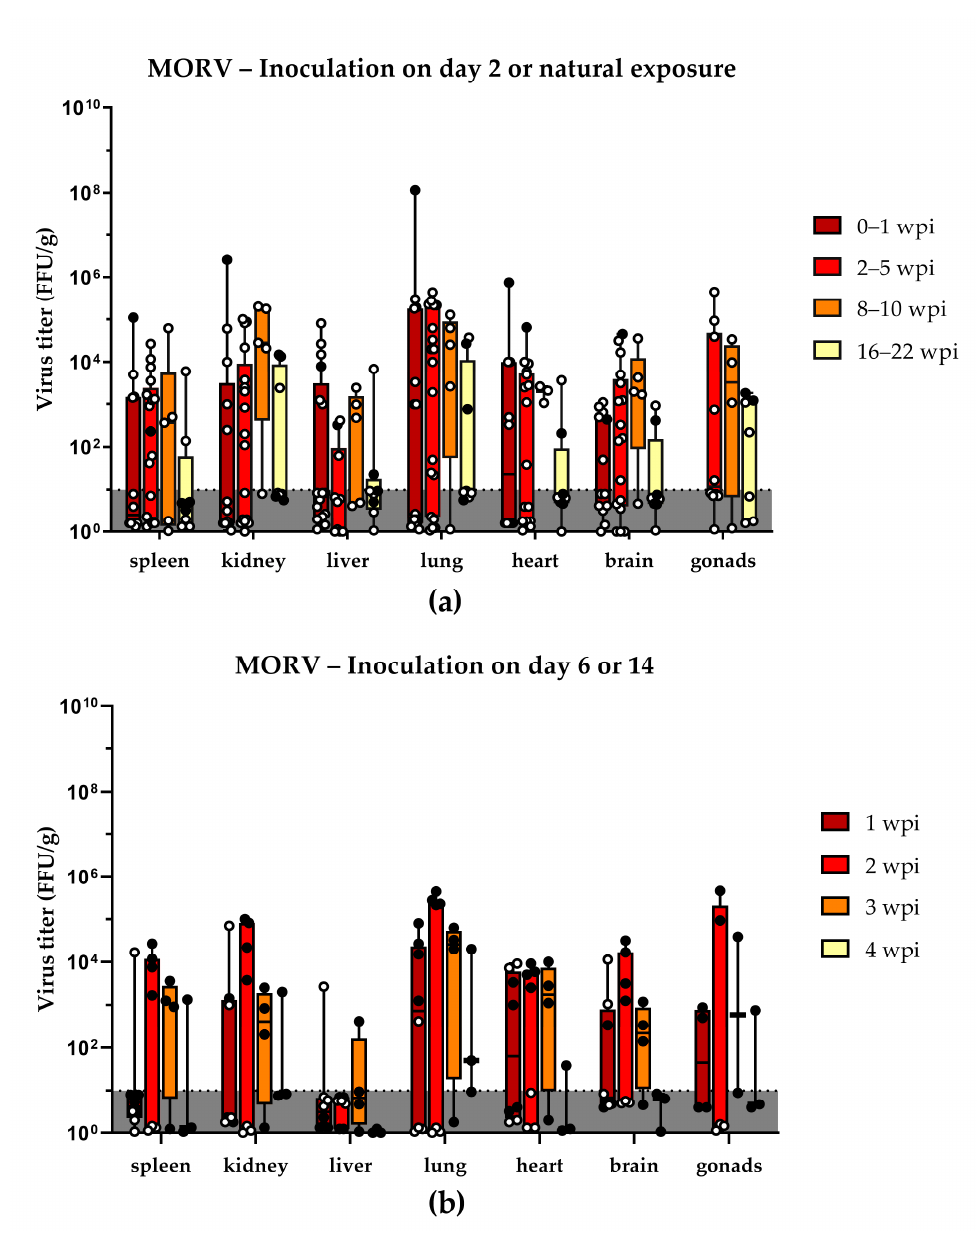
Figure 2. Organ titers of MORV-infected animals: ( a ) virus titers of organs from Mastomys that have been infected via inoculation 2 days post-birth (black dots) or via natural contact with infected individuals (white dots); ( b ) virus titers of organs from animals that have been inoculated 6 days (black dots) or 14 days (white dots) post-birth. The different time points post-infection are shown in different colors, and all samples falling into this time frame have been pooled. The limit of detection is shown by the dotted line and dark grey coloration. Titers are shown as box and whisker plots with all data points shown. Virus titers of negative samples (below the limit of detection) appear to vary due to the differences in organ weight, which is taken into account for the virus titer per gram organ.